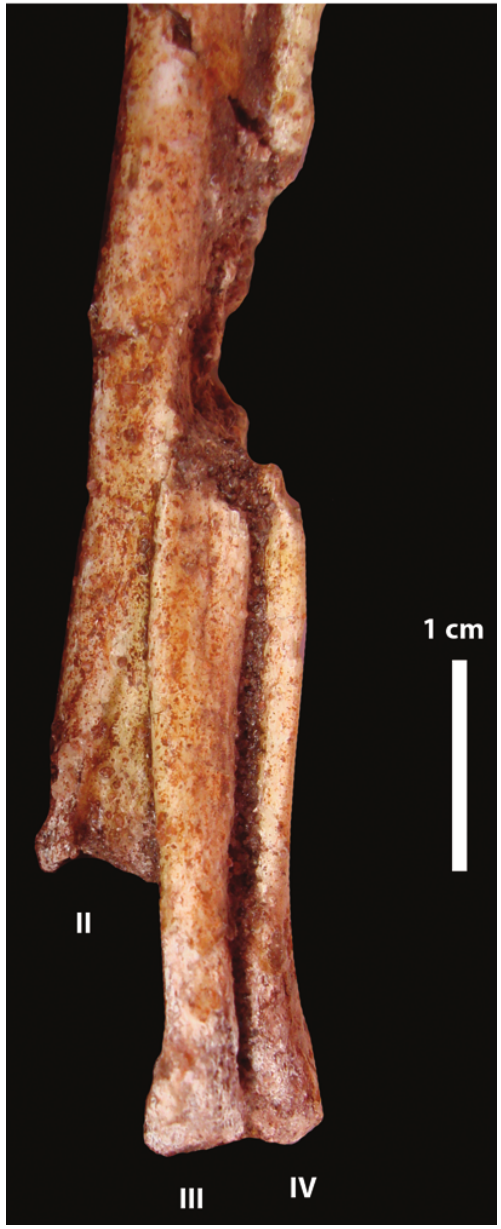
Fig. 5 – Distal end of metatarsals in anterior